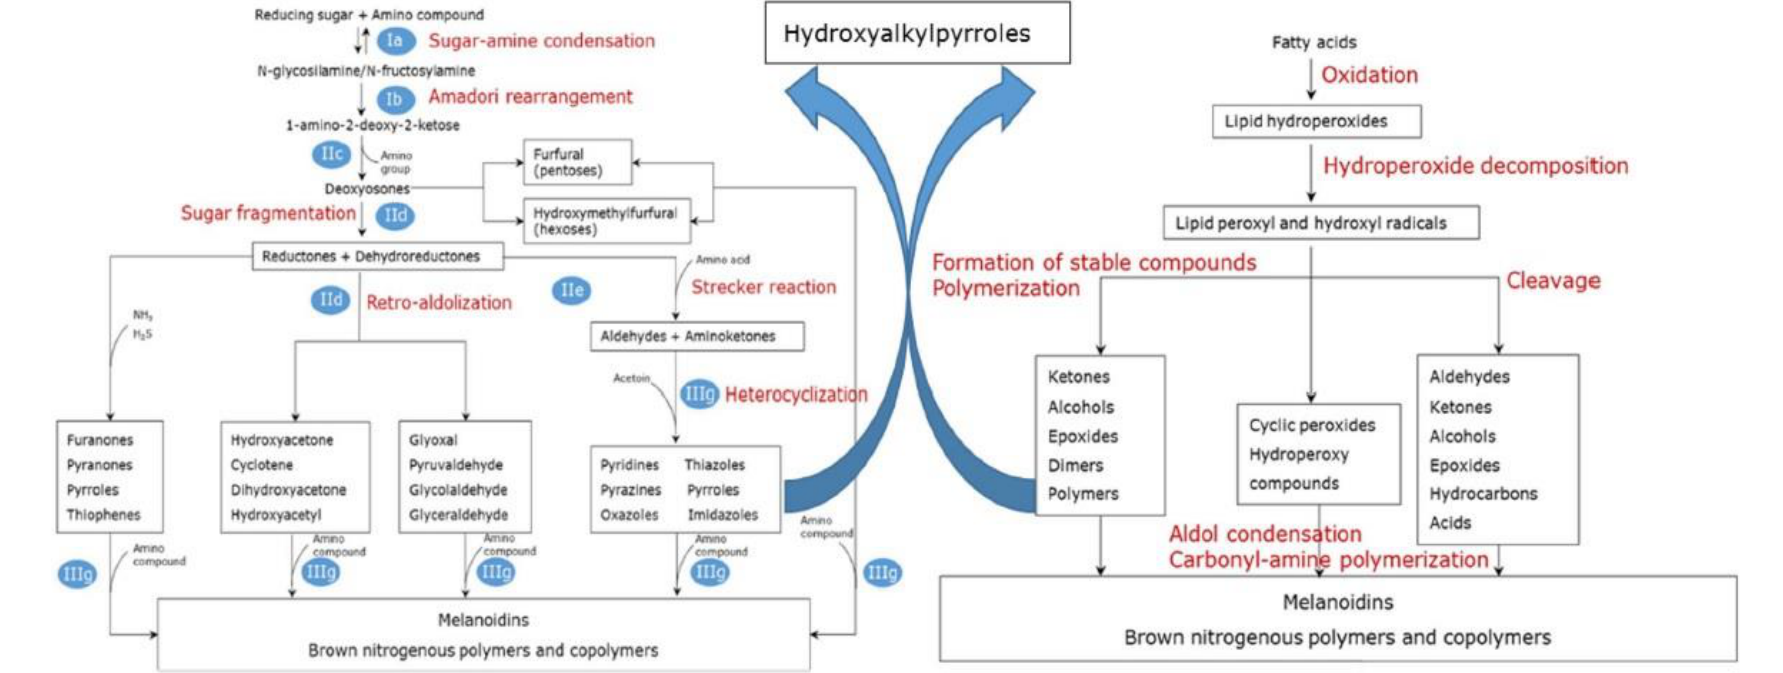
Figure 1. Overview over the routes of formation and common volatile compounds formed by the Maillard reaction and Strecker degradation, lipid oxidation, and their interaction. Reprinted from Diez-Simon et al. (2019) [14] with permission from Springer Nature under the terms of the CC BY license.